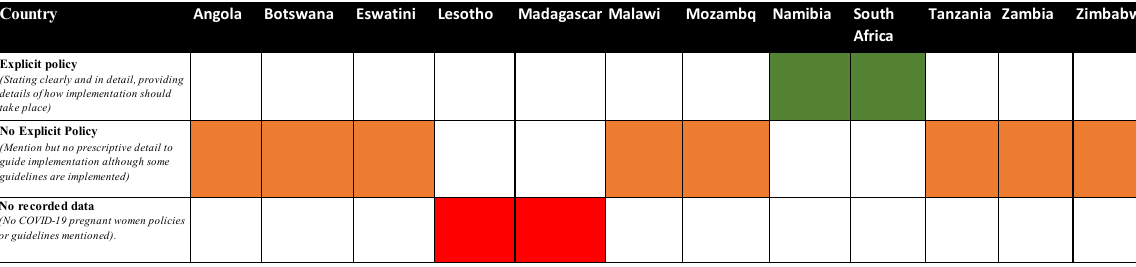
Figure 1. Indication of COVID-19 vaccination policies for pregnant women by country .